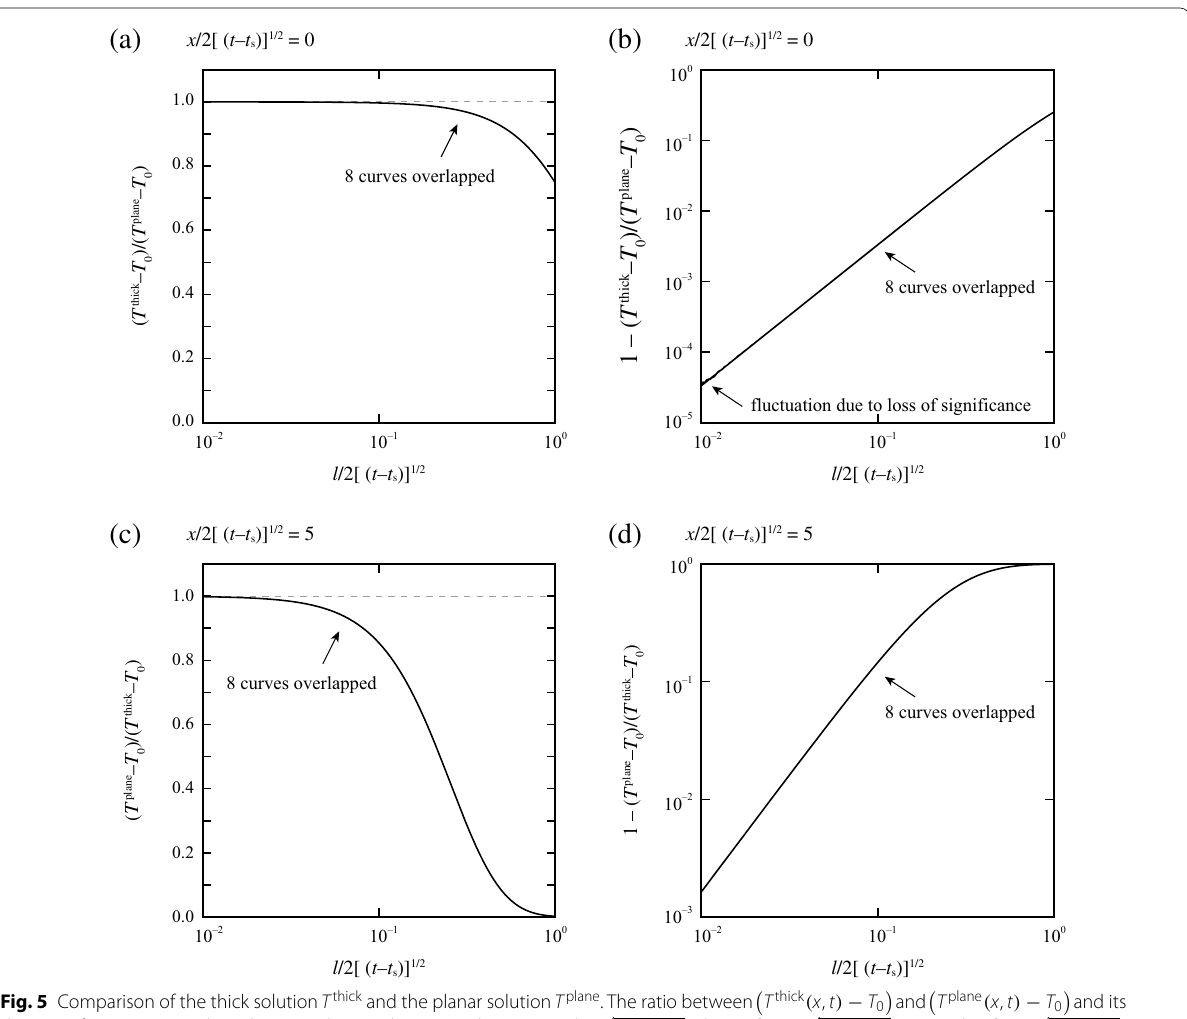
t x / 2 √ α( t t x / 2 √ α( t t s ) when a , b s ) = 0 , and c , d s ) = 5 , − − −